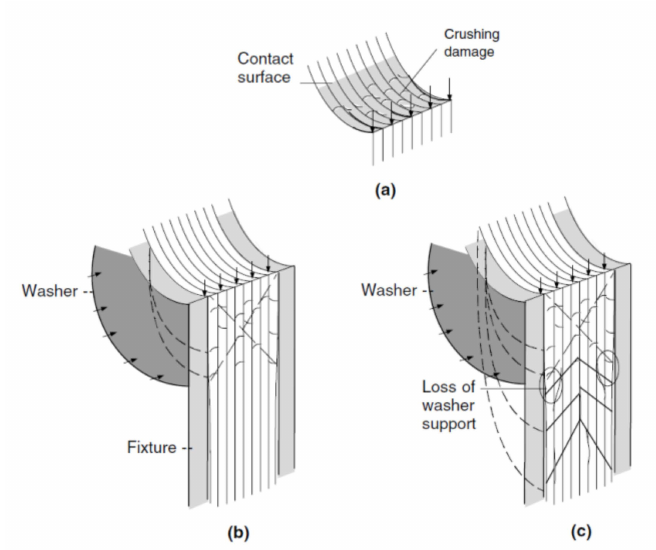
Figure 2. Schematicpresentationofthebearingfailuremechanisms: ( a )crushingdamage, ( b )damage within lateral constraint (inside-washer region), and ( c ) damage without lateral constraint (outside-washer region)